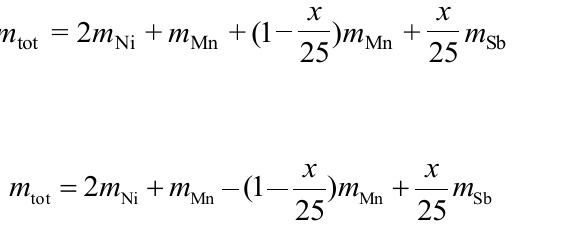
Figure 6. ( a ) Temperature dependence of the spontaneous magnetization, I s , obtained with the Arrott plot (μ 0 H / M - M 2 plot) by magnetization curves. Inset is an example of the Arrott plot at 4.2 K; ( b ) Concentration dependence of I s measured at 4.2 or 5 K for various Ni-based metamagnetic shape memory alloys of Ni(Co)MnIn, Ni(Co)MnSn and NiMnSb alloys [45,46]. Open symbols are I s for the ternary alloy systems of Ni 50 Mn 50− x In x (○), Ni 50 Mn 50− x Sn x (□) and Ni 50 Mn 50− x Sb x (∆), and closed symbols are those for their Co substituted systems. Dashed lines of cal.(1) and cal.(2) are expected by Equations (5) and (6),